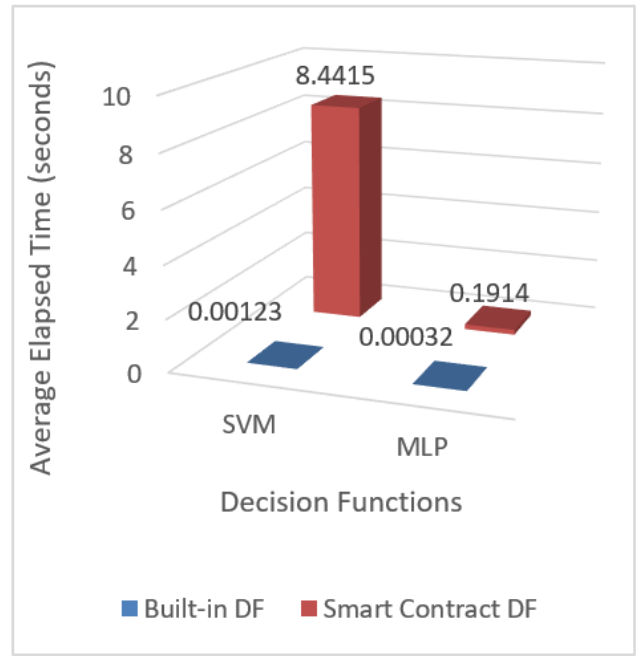
Figure 4. Elapsed time of SVM and MLP